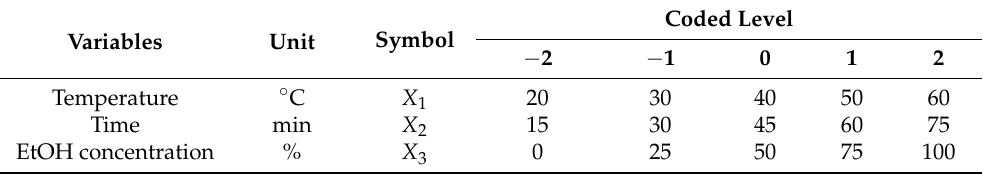
Table 1. The selected variables and their coded levels for the central composite